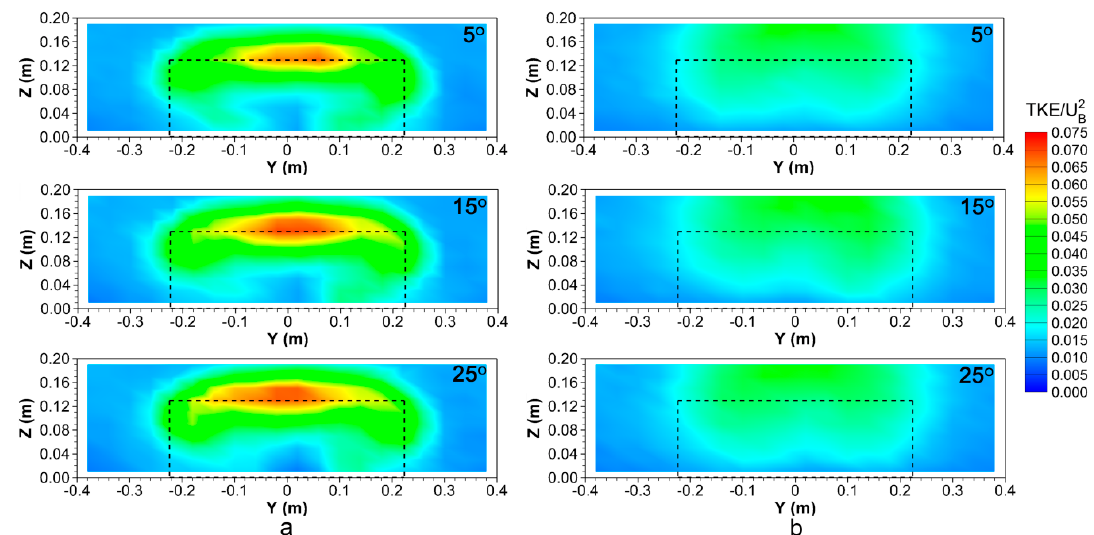
Figure 11. Spatial distributions of turbulence kinetic energy ( TKE ) normalised by the square of the air velocity at the building height ( U B 2 ) at Plane 1 ( a ) and Plane 2 ( b ) for roof slopes of 5°, 15°, and 25°. Black dash lines indicate the profile of the scaled model.